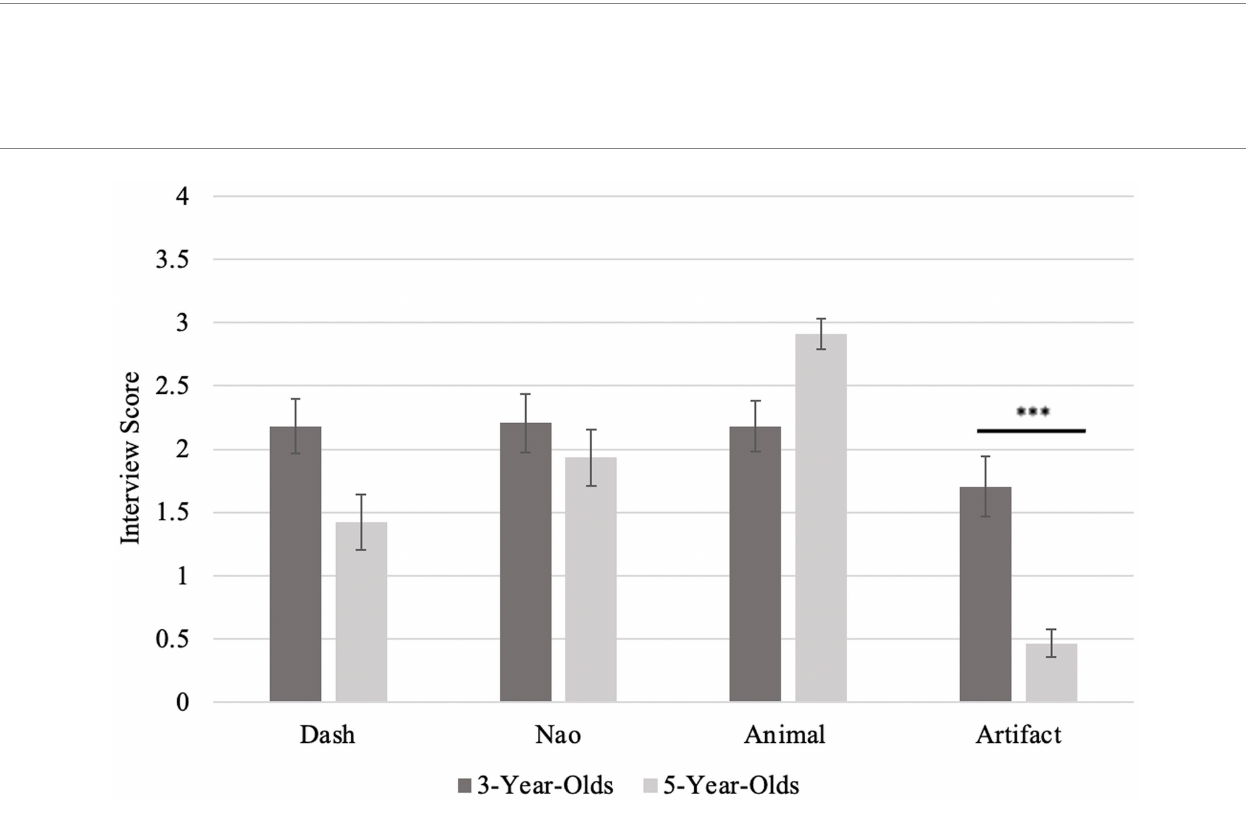
FIGURE 5 Score on animacy interview by item type, as a function of age. Error bars represent standard error. Higher scores represent more anthropomorphizing (with a maximum score of 4). The *** ( p < 0.001) indicates a significant difference between the two age group on that